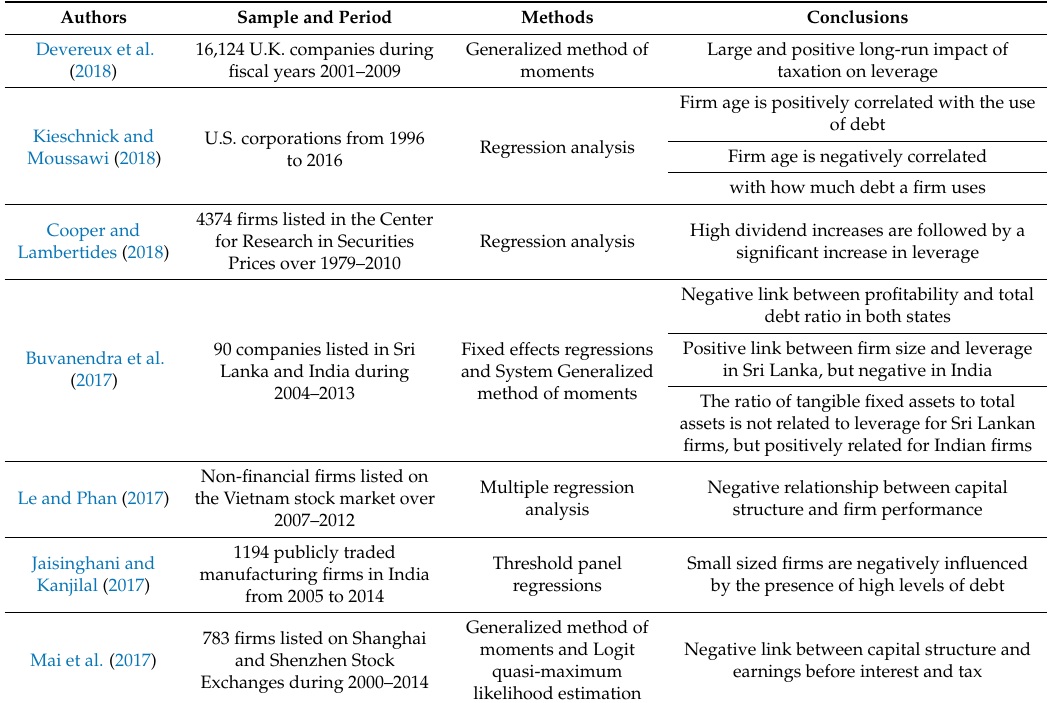
Table 2. Brief review of literature on capital